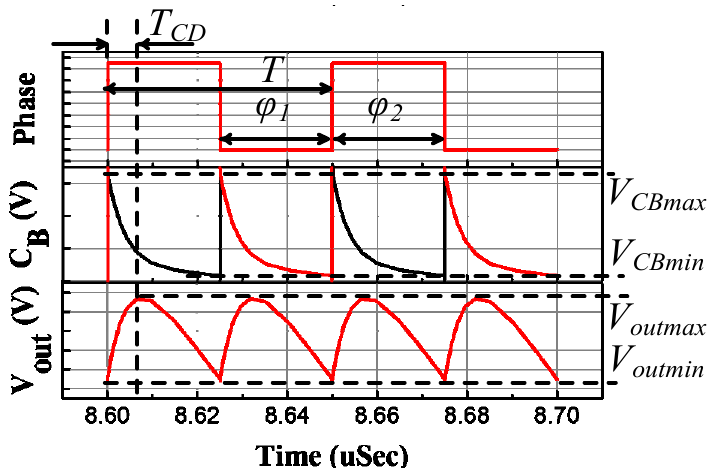
Figure 13. Voltage waveforms of phase control signal, C B , and output load V out .